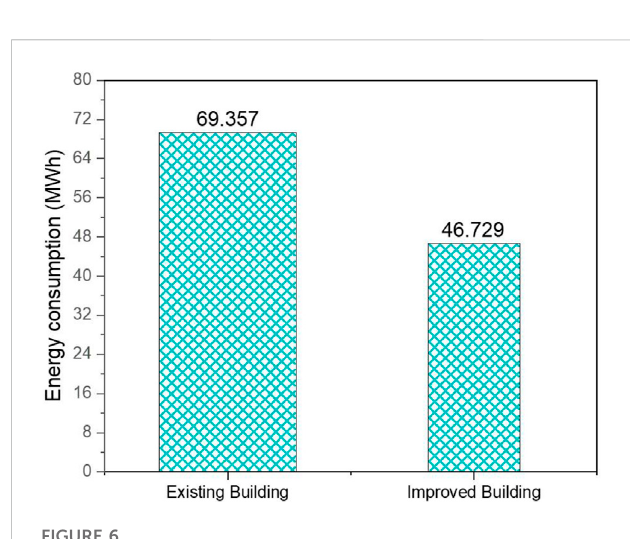
FIGURE 6 Energy consumption in the selected building before and after retro fi